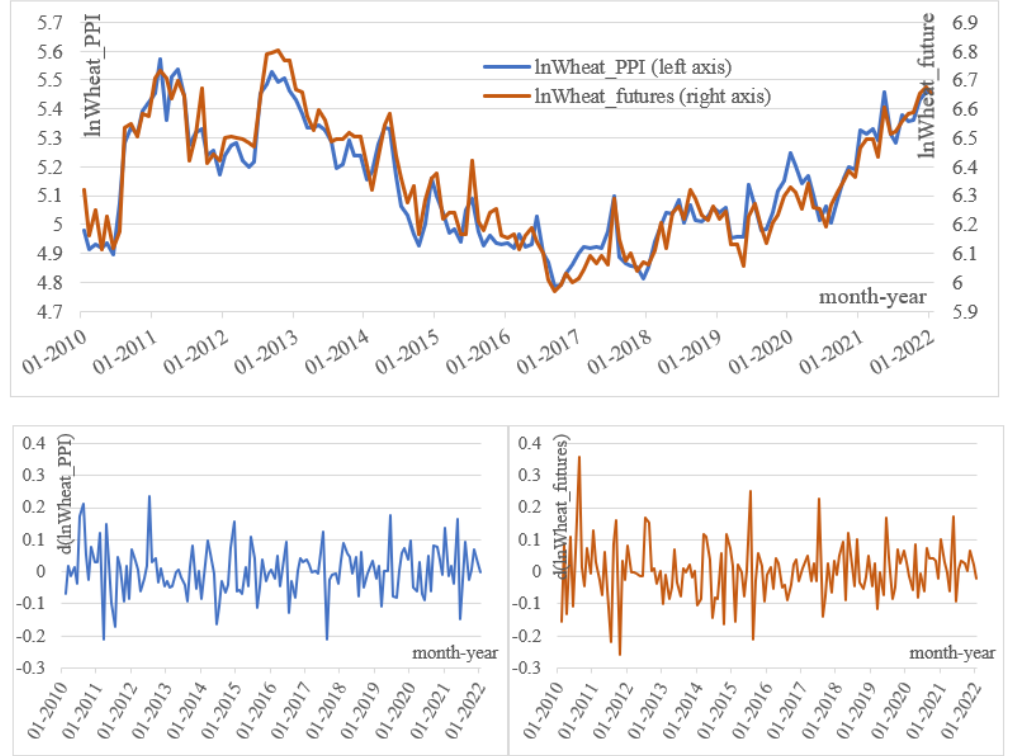
Figure 1. Quotations and relative increments of wheat futures and cash prices in the US. There is a very strong relationship between cash prices and futures prices in the chart. These prices are very close to each other, as are the turning points of the periods of rising